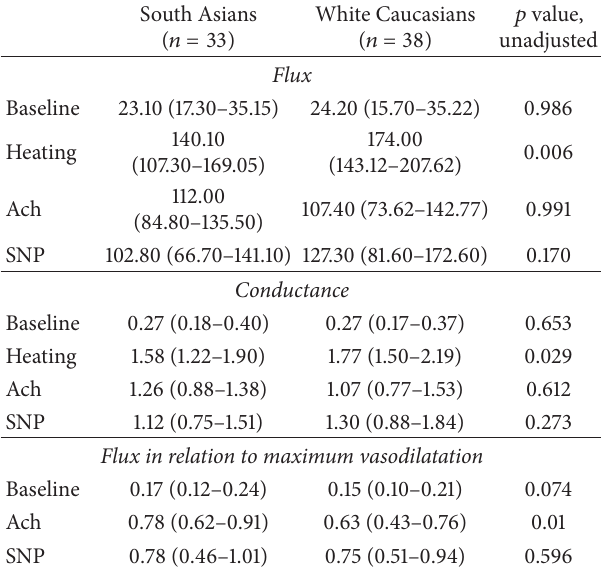
Table 4: Differences in heart rate variability, spectral analysis, and time-domain and frequency-domain parameters between South AsiansandWhiteCaucasianswithdiabetes.Nonsignificantcompar- isons from the HRV and frequency and time domain analysis have not been included. Data are presented as median (IQR).